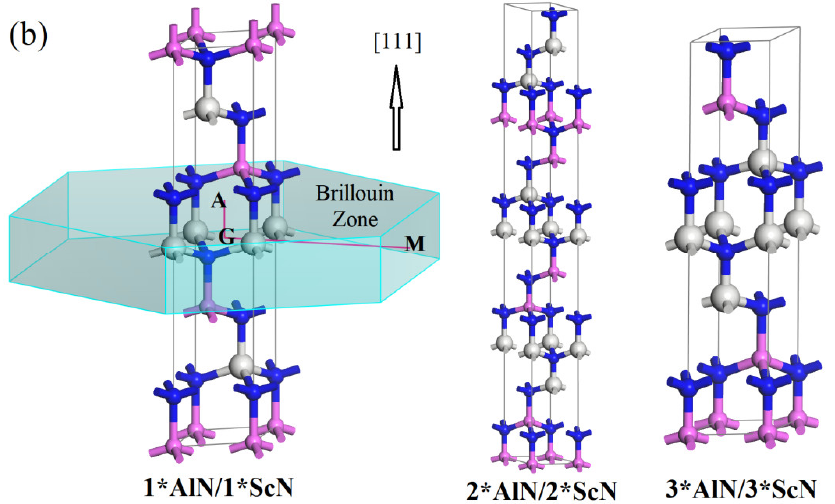
Figure 1. Crystal structures of n*AlN/n*ScN superlattices ( n = 1, 2, 3) on ( a ) (001) and ( b ) (111) crystallographic faces of wurtzite structure, as indicated by layer-plane normal along (001) and (111) crystallographic orientations respectively, and the dispersion paths of electronic energy band through high symmetry points in the Brillouin zone are also shown. The gray, pink, and blue balls symbolize Sc, Al, and N bonding atoms, respectively. Table 1. The space symmetry group, lattice constant ( a / b , c ), thicknesses of AlN and ScN constituent layers ( h AlN and h ScN ), and cohesive energy per atom ( E coh ), band gaps E g and intrinsic breakdown field strength E b for the AlN/ScN superlattices.